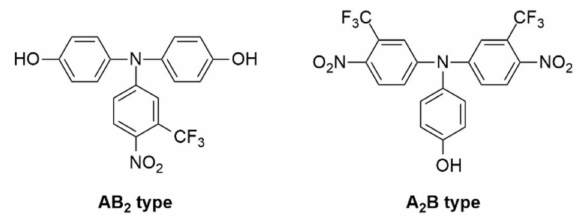
Figure 1. Monomer